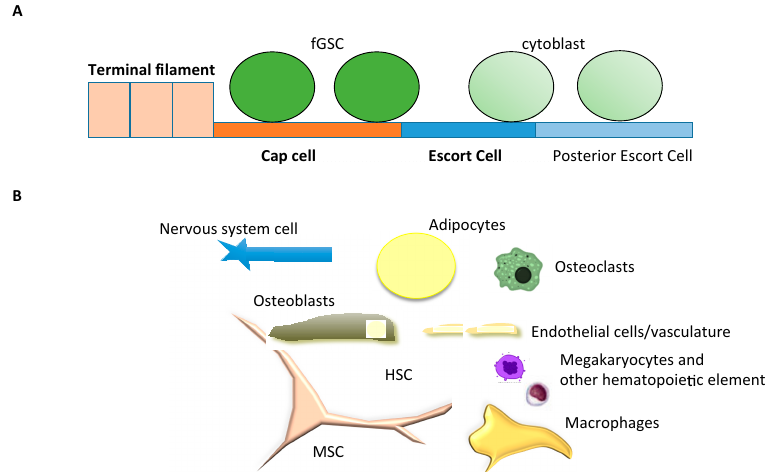
Figure 5. Comparison of niche components in the female germinal stem cell (fGSC) niche in Drosophila and the hematopoietic stem cell (HSC) niche in mouse: ( A ) The fGSC is a fixed niche, composed of three niche cells (terminal filament, cap cells and escort cells). Only cap cells contact fGSC directly; the rest interact with fGSC indirectly. Only fGSC and not differentiated cytoblasts contact cap cells; ( B ) The HSC is a complex niche composed of at least 9 different cell types that impact HSC biology. Mesenchymal stromal cells (MSC) are the cells with the most extensive and pervasive contact, but other cell types also contact HSCs.